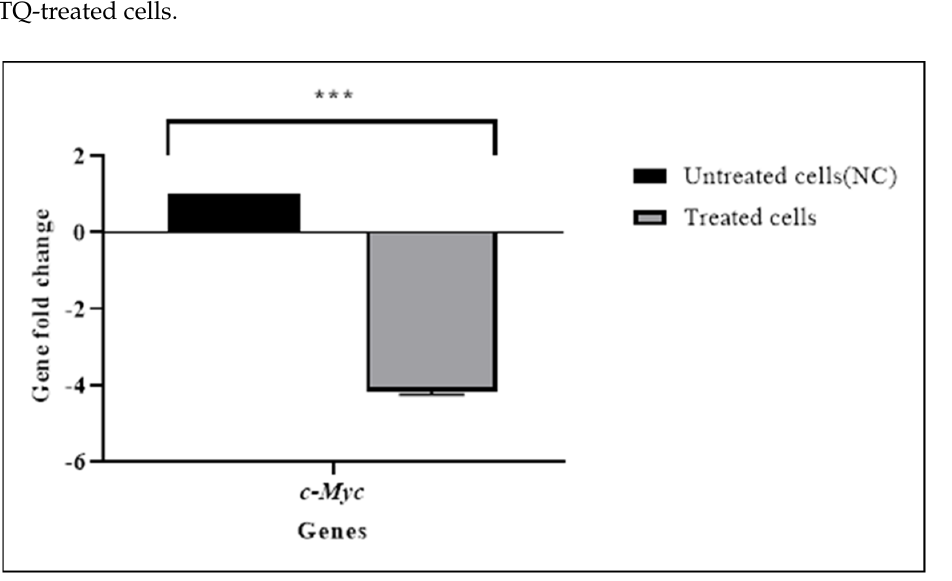
Figure 7. The c − Myc expression level was determined using a RT − qPCR assay in HL60 cells. RT − qPCR revealed that TQ significantly downregulated c − Myc gene expression by 4 − fold in treated cells, and the untreated cells were used as a negative control group. Data are presented as the mean ± SEM (*** p < 0.001).